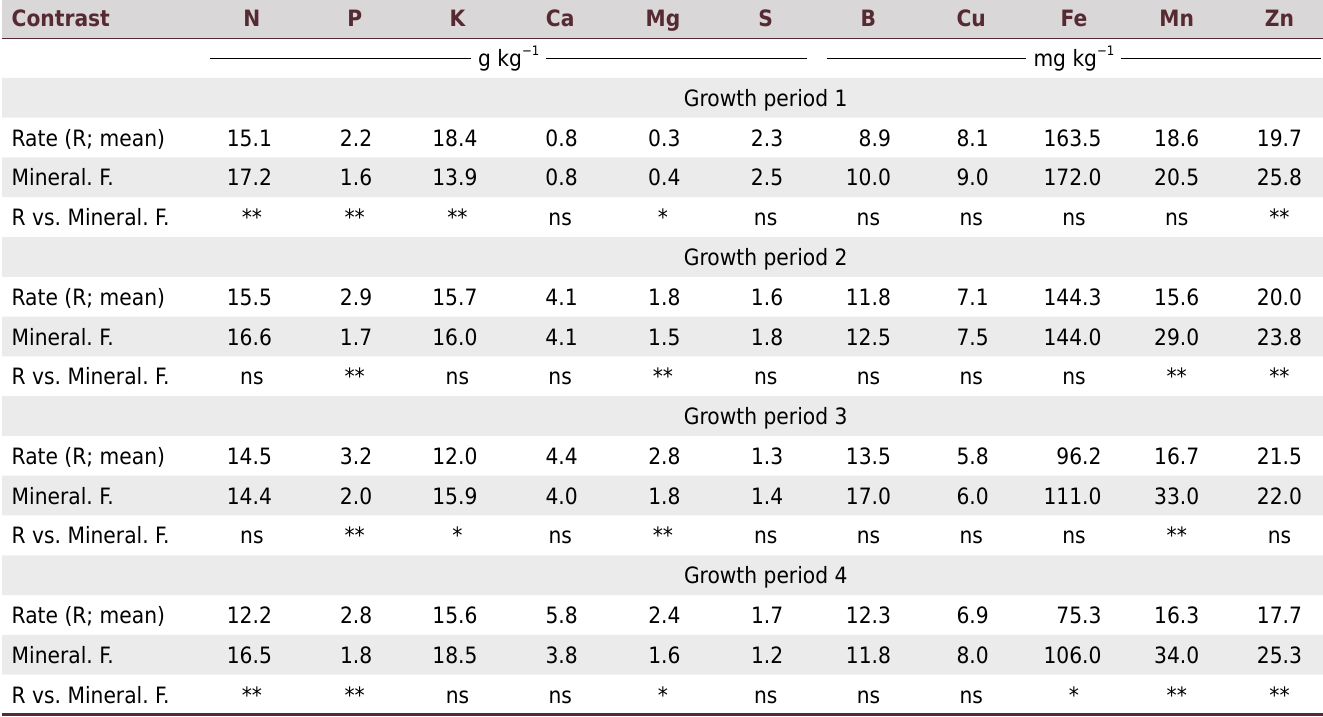
Table 7. Mean values and contrast analysis for nutrient contents in the elephant grass sample leaf in response to organic compost rates and mineral fertilization Contrast N